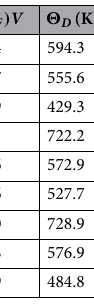
Table 3. The effective electron–phonon coupling potential N ( E F ) V and calculated values for the Debye temperature, (cid:31) D , for the MAX phases studied.